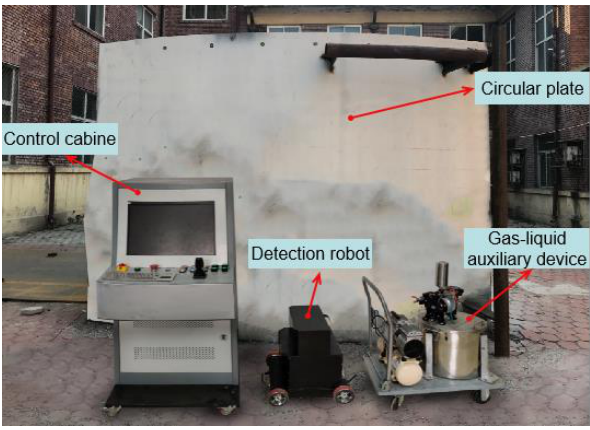
Figure 10. Experiment platform.